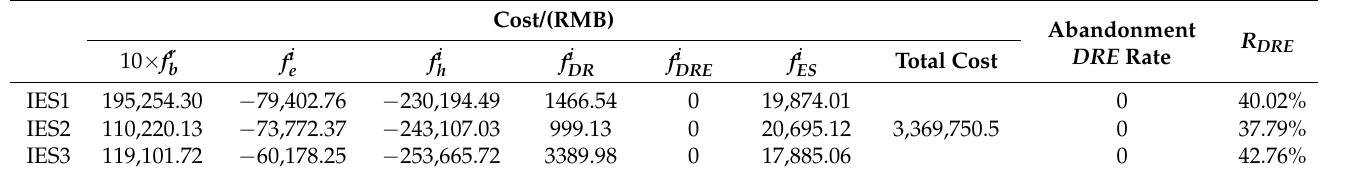
Table 9. Model optimization results.